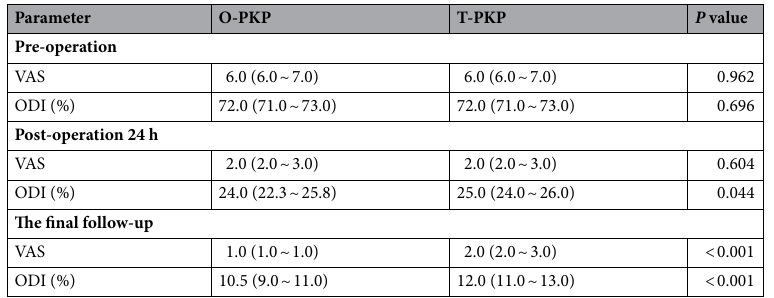
Table 2. VAS and ODI scores were evaluated at pre-operation, post-operation 1 day and the final follow-up between groups. The VAS and ODI scores were analyzed using the Friedman rank sum tests, due to these data did not conform to a normal distribution, these data expressed as medians (IQR).